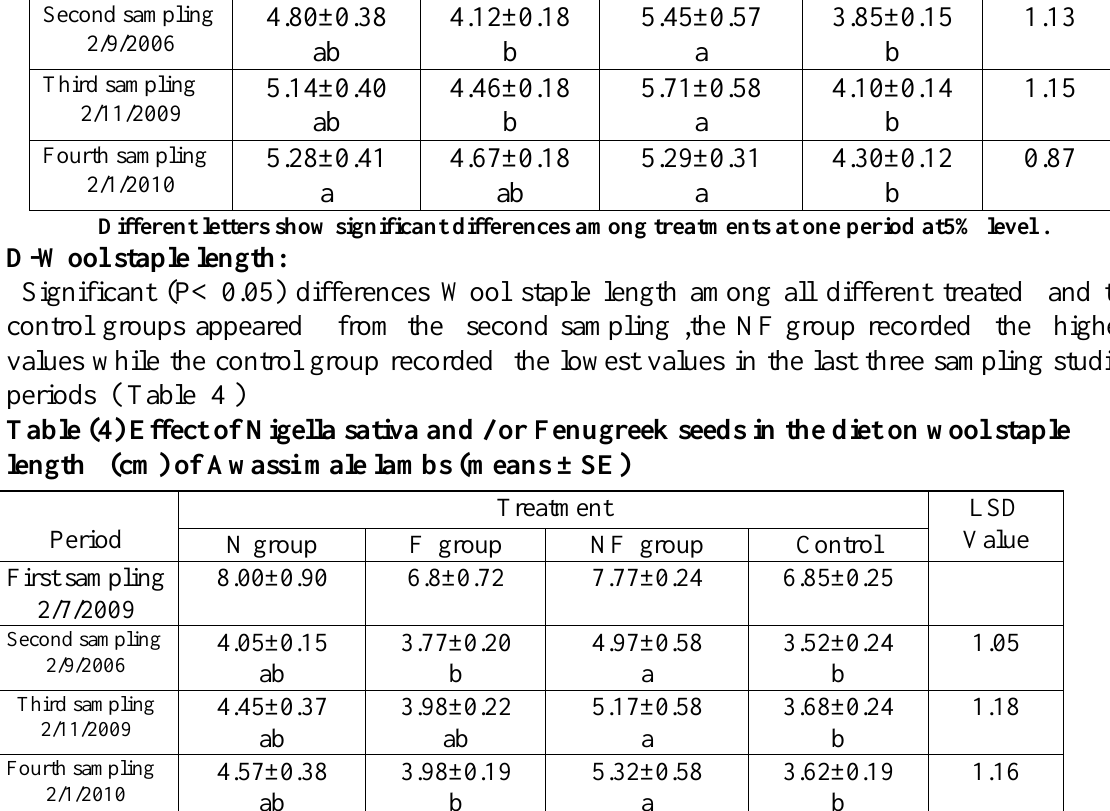
Different letters show significant differences among treatments at one period at5% level .